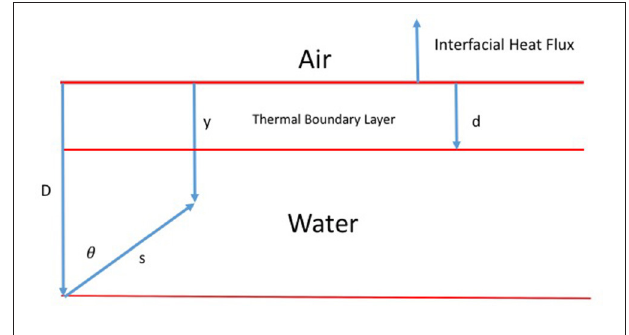
FIGURE 1 | The geometry associated with a radiation field at an air-water interface stratified in planes parallel to the water surface. The thermal boundary layer thickness is d , and the domain depth is D . Radiation propagates along a ray whose path length is s in direction θ